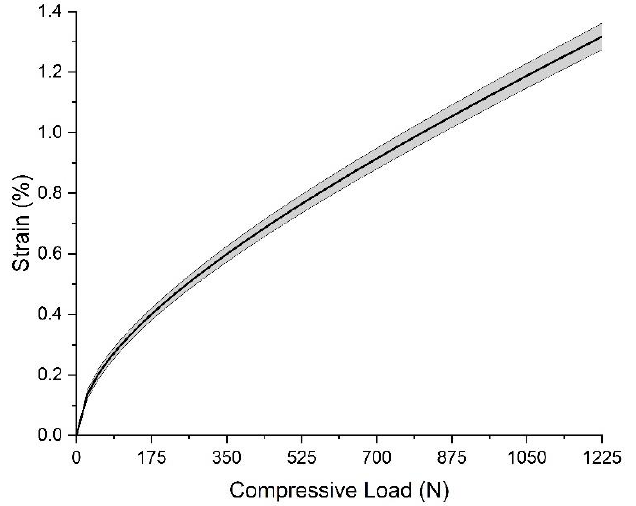
Figure 14. Strain of the assembly of the supporting part and the adaptor under the transverse compressive load.